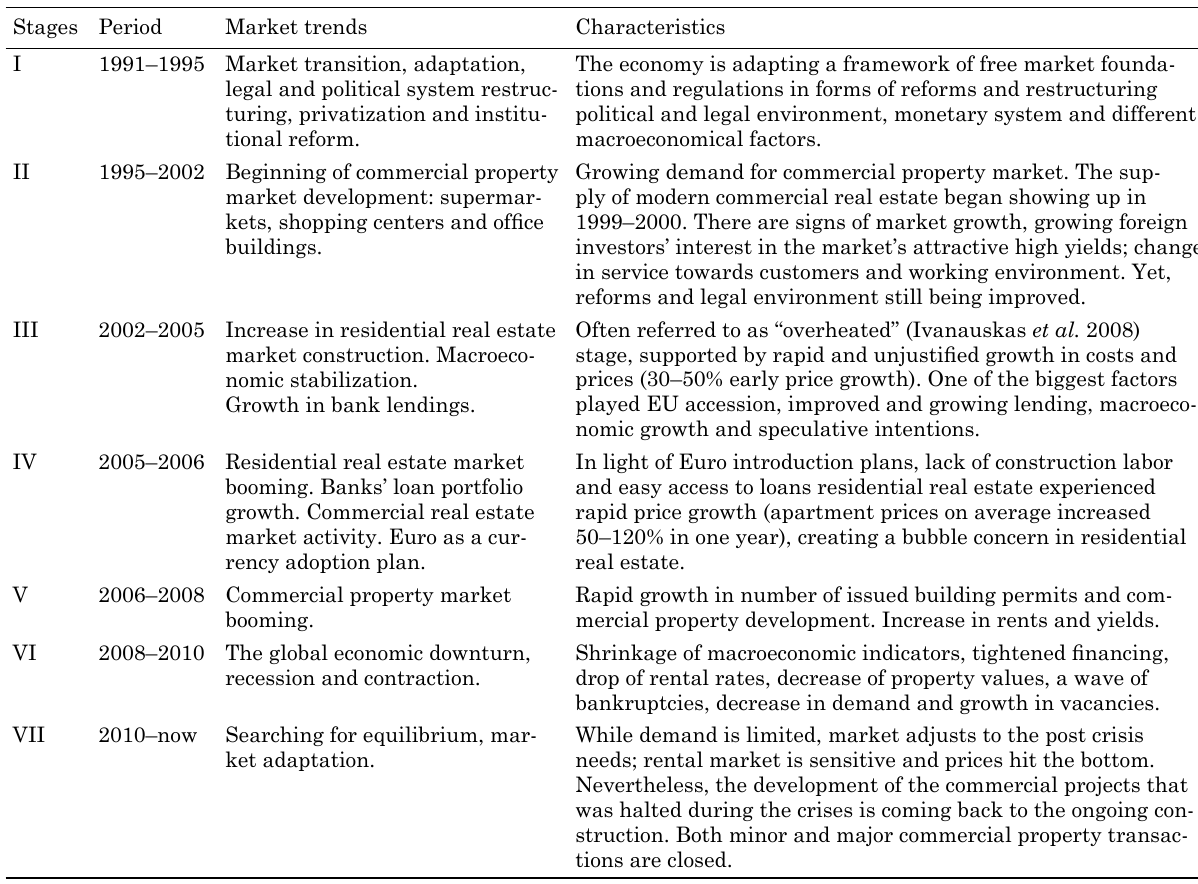
Table 2. Property market development and evolution in Lithuania Stages